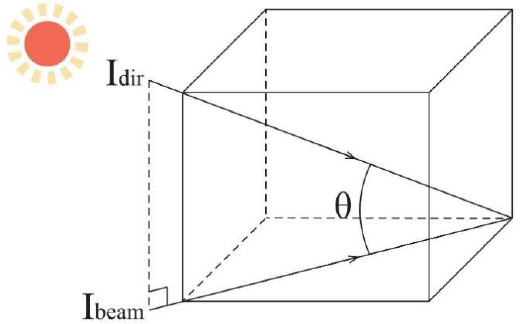
Figure 2. Schematic diagram of direct solar flux; drawn by the authors.